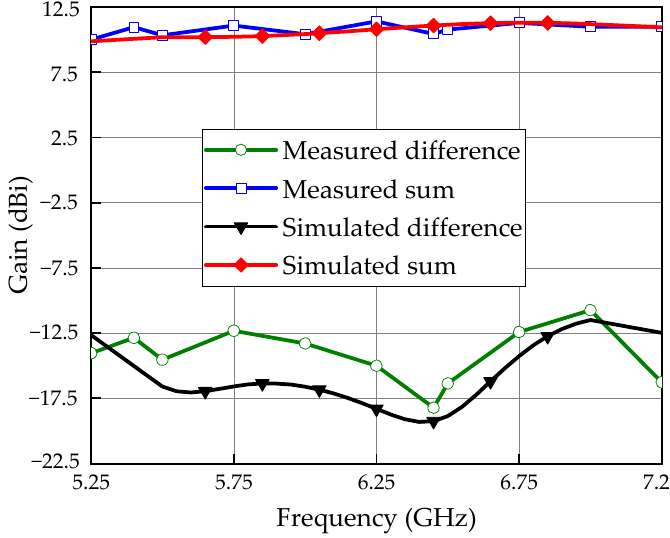
Figure 12. Simulated and measured gain of the antenna in endfire direction.